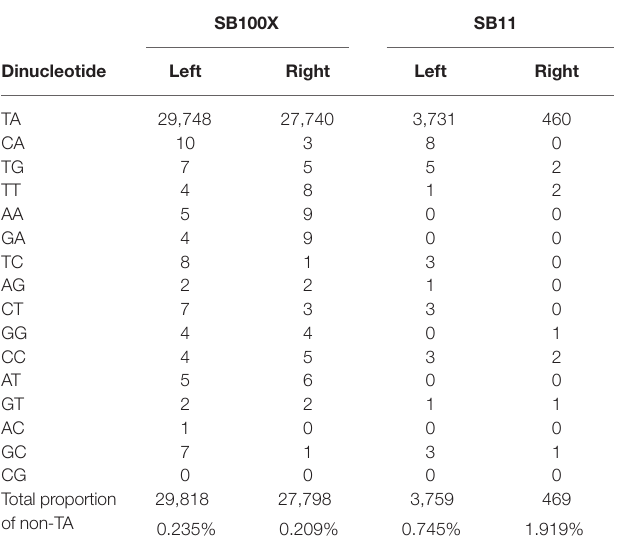
TABLE 1 | Number of integrations at different dinucleotides.